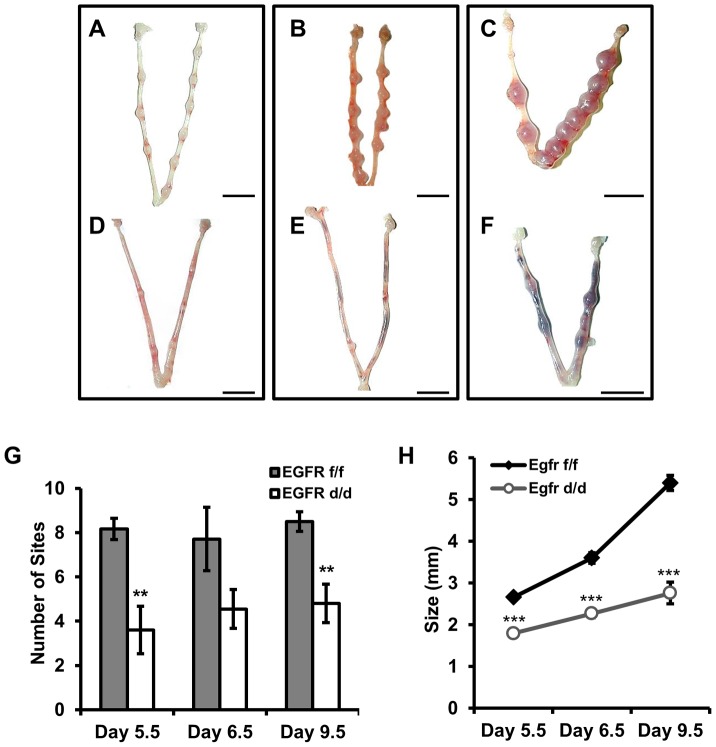

Egfr ablation causes blastocyst implantation site demise.(A–F) Gross morphology of pregnant uteri. (A–C) Egfrf/f and (D–F) Egfrd/d females were mated with wild-type males. The morning observance of a vaginal plug was considered day 0.5 of pregnancy. Pregnancy was assessed at (A,D) d5.5, (B,E) d6.5 and (C,F) d9.5. Scale bars: 1 cm. (G) Average number of implantation sites observed. (H) Average lateral diameter of implantation sites. Numbers represent average +/− the SEM. **-p<0.01; ***-p<0.001.